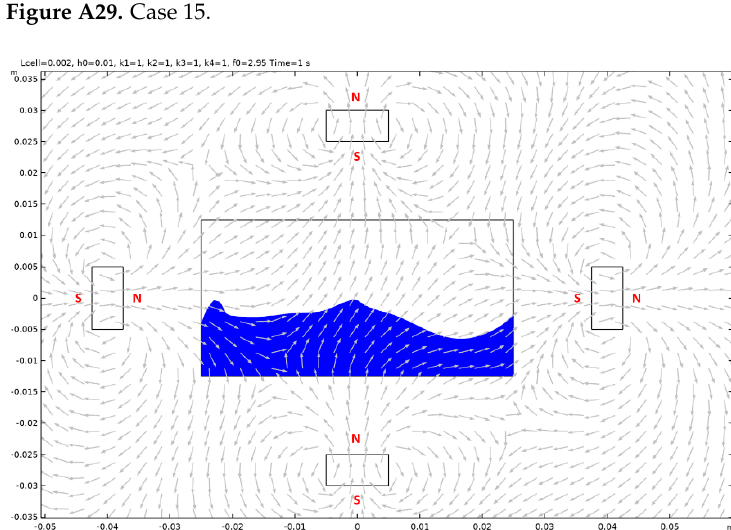
Figure A30. Case Figure A30. Case 16. Figure A30. Case 16.